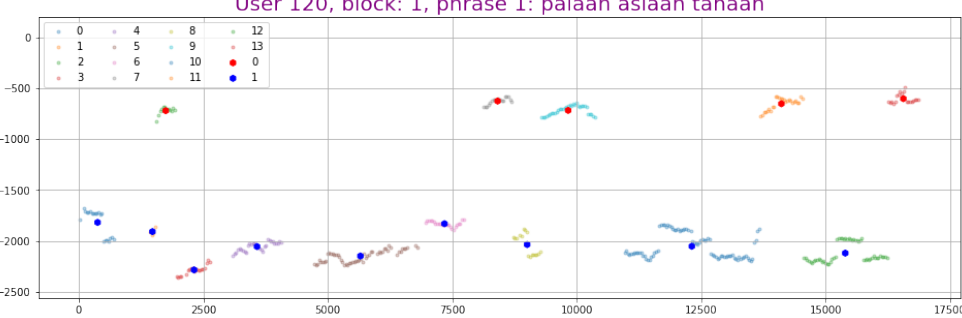
Figure 9. Example of the results from the DBSCAN clustering process (multicoloured clusters) and k-Means clustering of the mean vertical coordinate of the DBSCAN clusters (red and blue dots).